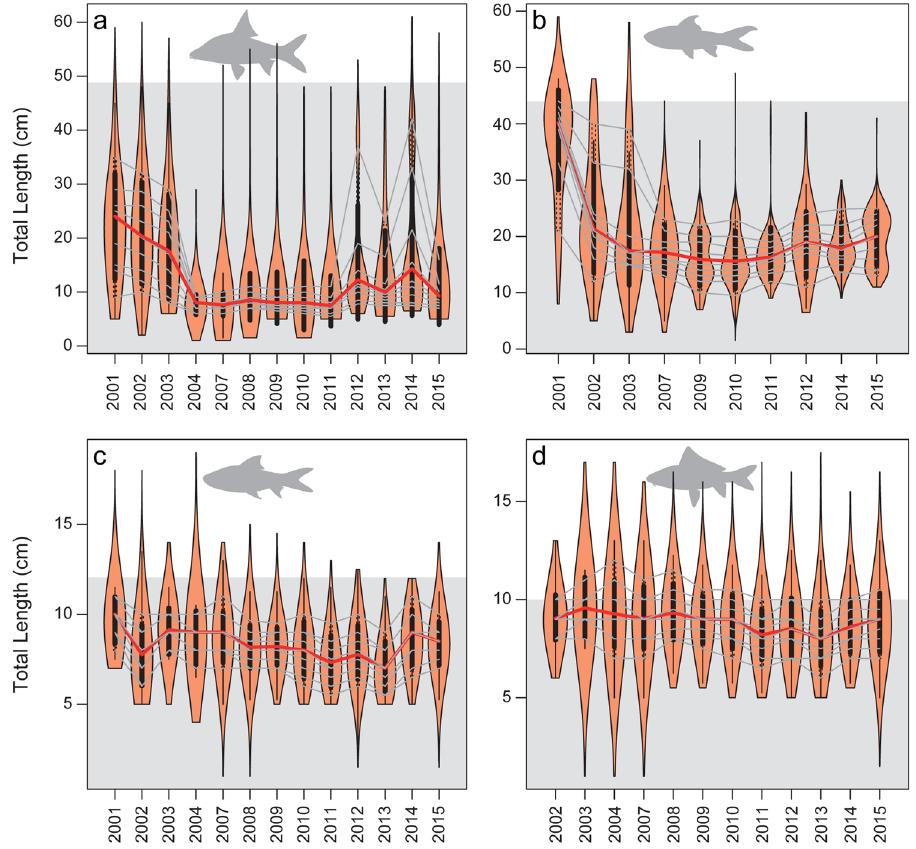
Figure 5. Violin plots show temporal shift in length distribution of four species ( a ): Cyclocheilichthys enoplos , ( b ): Cirrhinus microlepis ; ( c ): Henicorhynchus lobatus ; ( d ): Labiobarbus lineatus from the fishing season of 2000/01 to 2014/15. Red solid line symbolizes median body size in each fishing season and grey thin lines indicate decile, dividing ten equal groups of a population. Area above the gray shaded area denotes estimated total length at maturity for each species. 2001 represents the fishing season of 2000/01 and the same for other